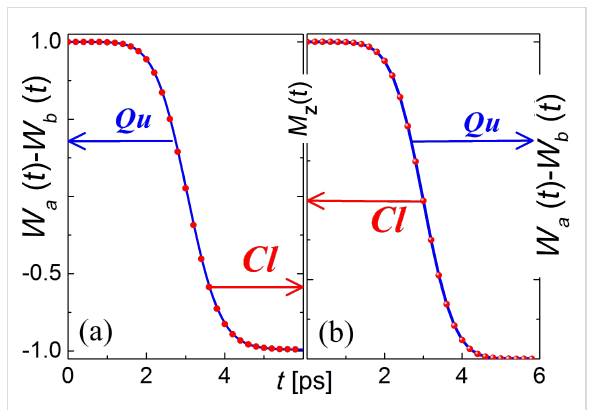
Figure 5: The ground level population dynamics of both the atomic- based qubit for an oscillating magnetic field impact (a): µ 12 = 10µ 0 , ω l = ω 12 = Ω L ≈ 2·10 13 Hz, H 0 ≈ 1.37 T, τ = 1 ps) and the flux qubit system for a unipolar magnetic field impact (b): µ 12 = 10 6 µ 0 , ω l = 0; ω 12 = Ω L ≈ 10 10 Hz, H 0 ≈ 0.1 Oe, τ = 1 ps) in comparison with the predictions of the Landau–Lifshitz–Gilbert equation ( ) for the Z -projection of the magnetization behavior. The filled circles are classical calculations and the solid lines are the results for the quantum model.